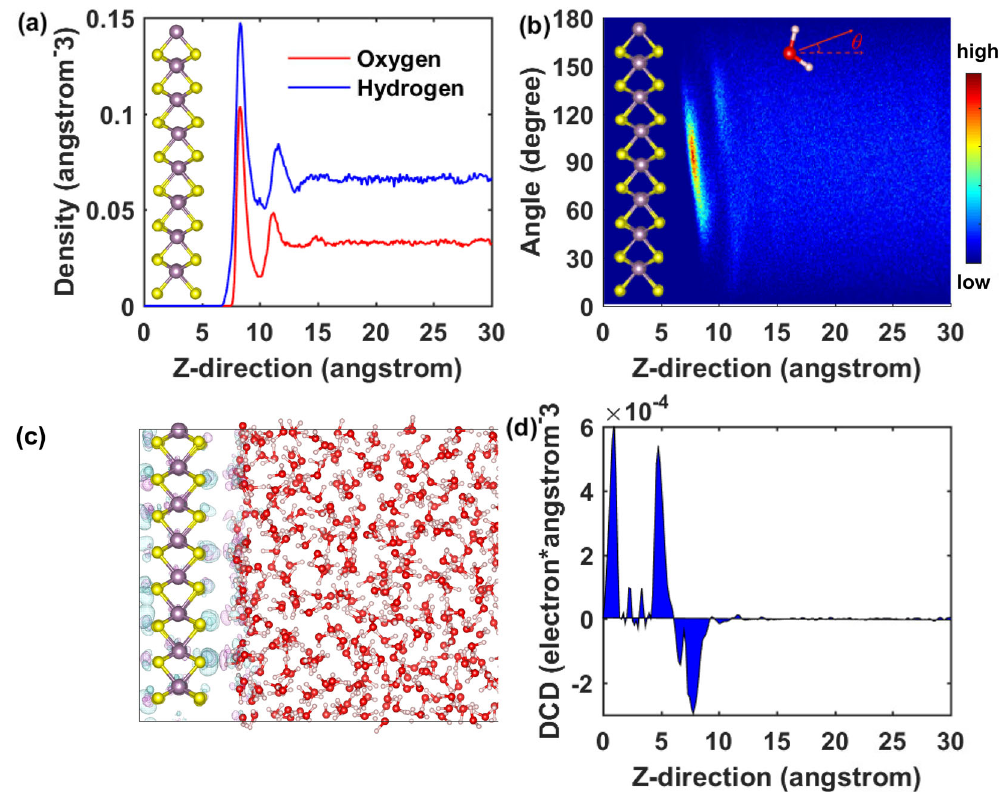
Fig. 3 Water dipole and differential charge density for the combined MoS 2 /water system. a Laterally averaged number density of oxygen and hydrogen atoms for 10 6 con fi gurations over a 10 ns time span of the MD simulation. b Dipole orientation of water molecules in the combined MoS 2 /water system. c Differential charge density (DCD) for the sampled con fi guration at the MD simulation time of 1 ns. The isosurface value is set at 6 × 10 − 9 e Å − 3 . Charge accumulation (blue) is seen near the sulfur atoms and reduction (purple) near the hydrogen atoms at the MoS 2 /water interface. d The laterally averaged DCD along the